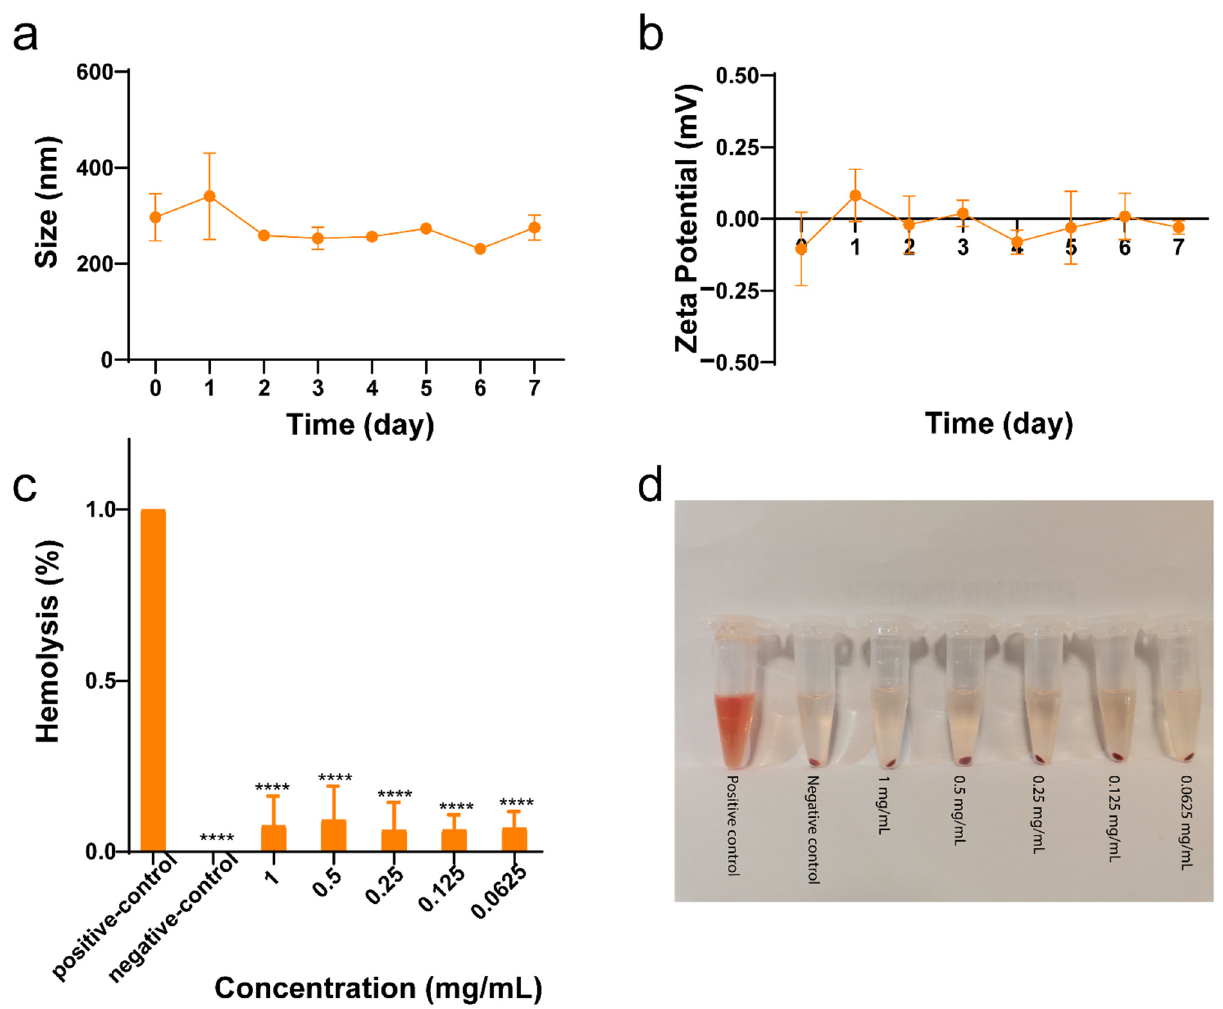
Figure 3. Stability of CaF 2 : Ce, Gd, Nd NPs. ( a ) Size of CaF 2 : Ce, Gd, Nd NPs in 50% FCS; ( b ) Zeta potential of CaF 2 : Ce, Gd, Nd NPs in 50% FCS; ( c ) hemolysis of CaF 2 : Ce, Gd, Nd NPs after incubation with red blood cells at multiple concentrations (0–1 mg/mL) for 4 h, with PBS and deionized water serving as negative and positive controls, respectively; ( d ) hemolysis photo after centrifugation. All data presented the mean values ± SD from three independent trials. By comparing experimental groups to control group, one-way ANOVA was used to determine statistical significance (**** p <